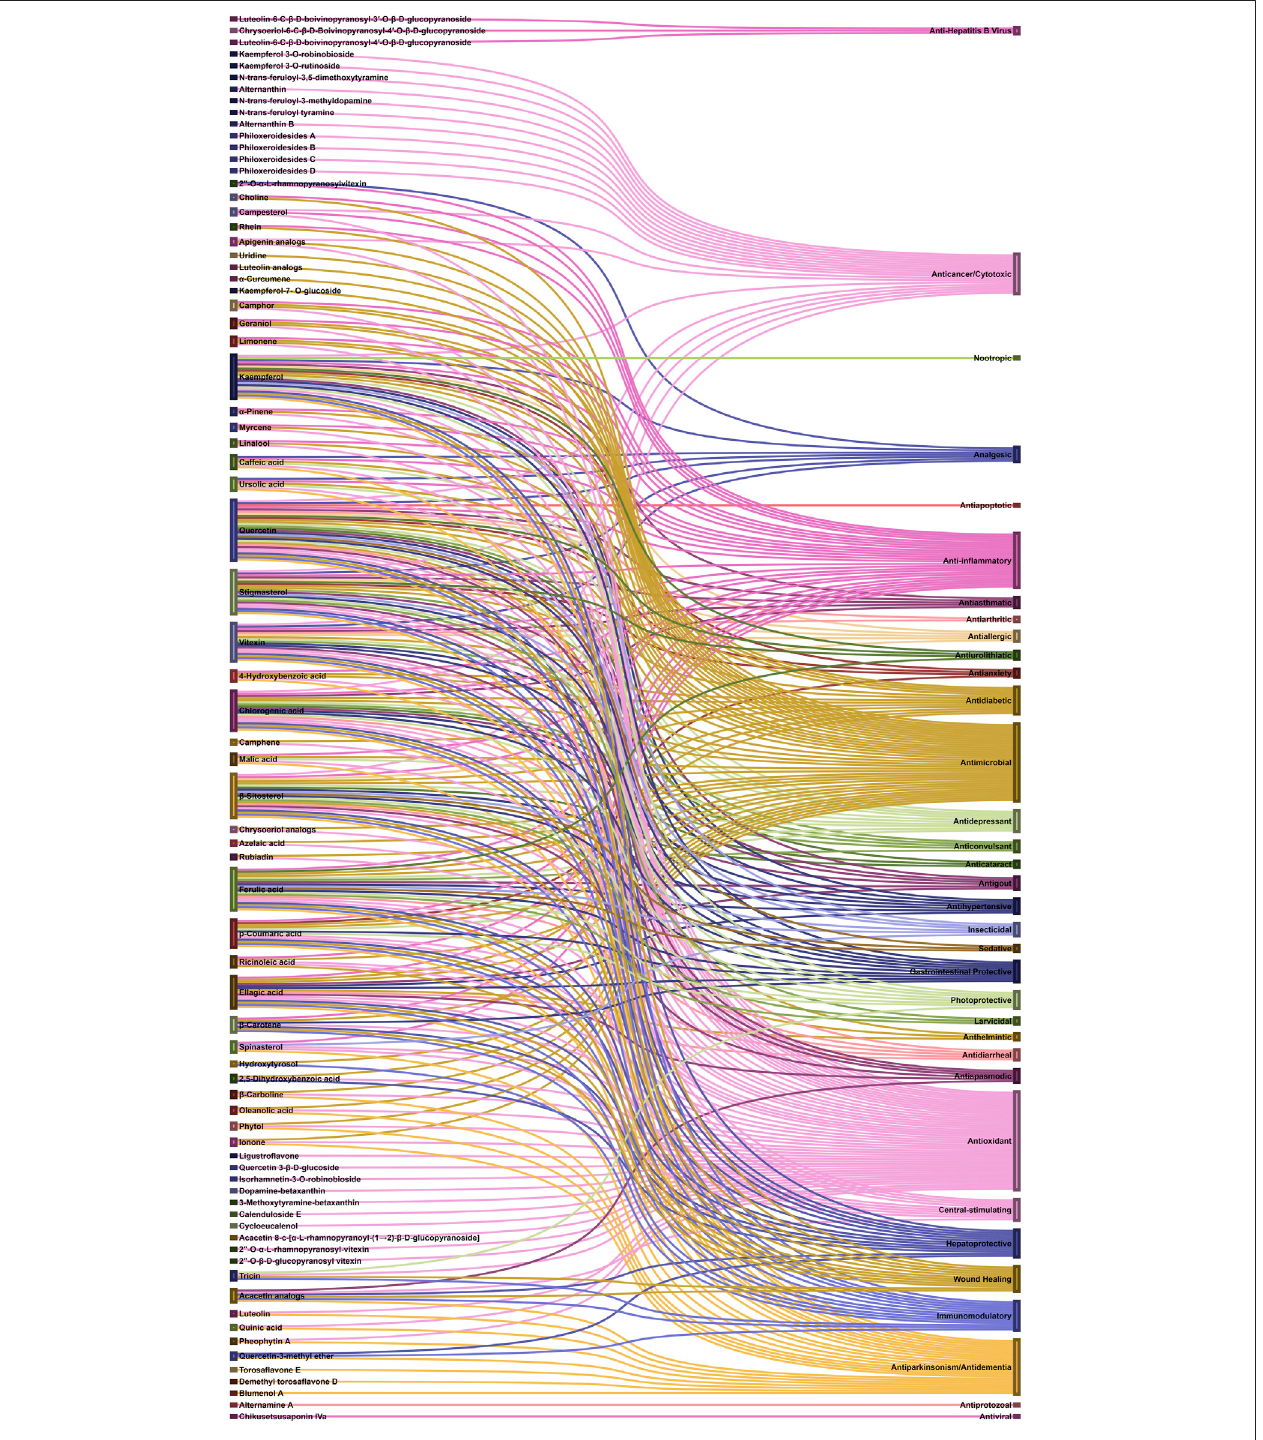
FIGURE4| BioactiveMoleculesandtheirelicitedpharmacologicalactivities.Thisinformationwascollectedasacross-sectionalliteraturereviewwhileexploringthe possible bioactive molecules behind the pharmacological activities of the crude extracts obtained from various species of Alternanthera Genus.